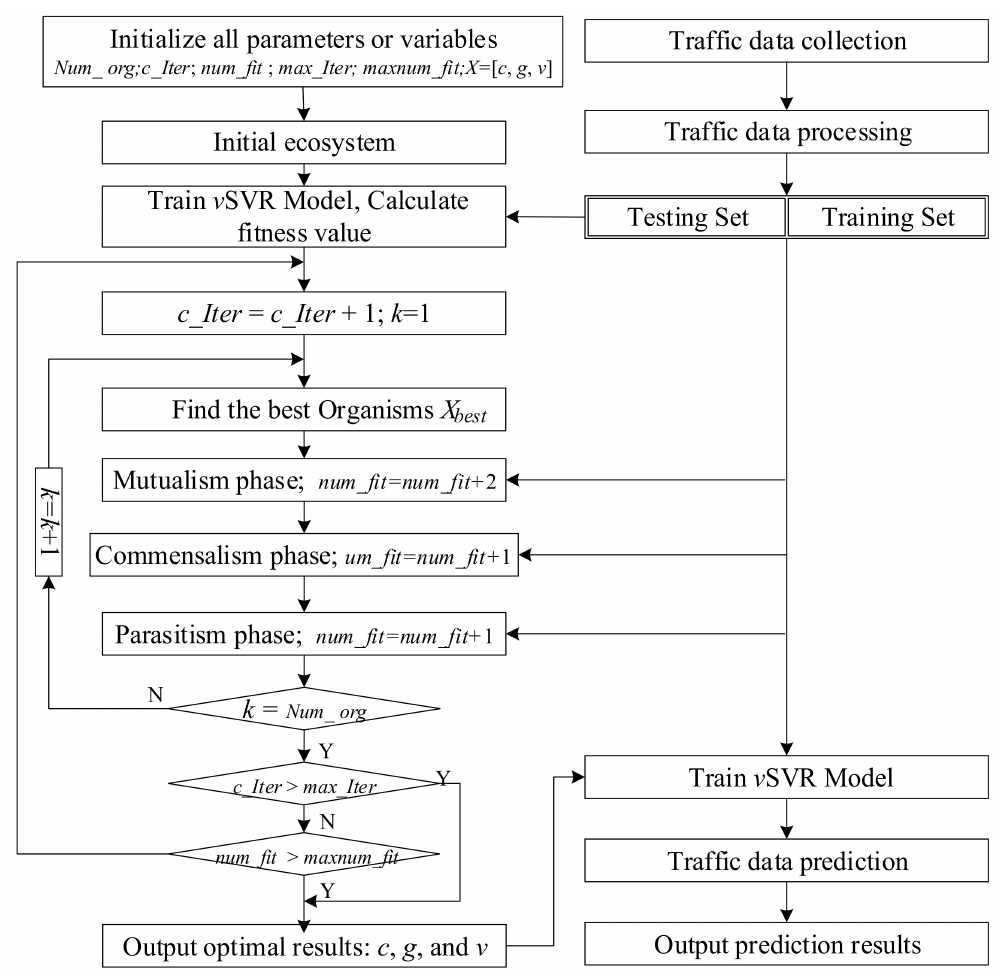
Figure 1. The flowchart of symbiotic organisms search (SOS) optimized µ support vector regression ( v SVR).